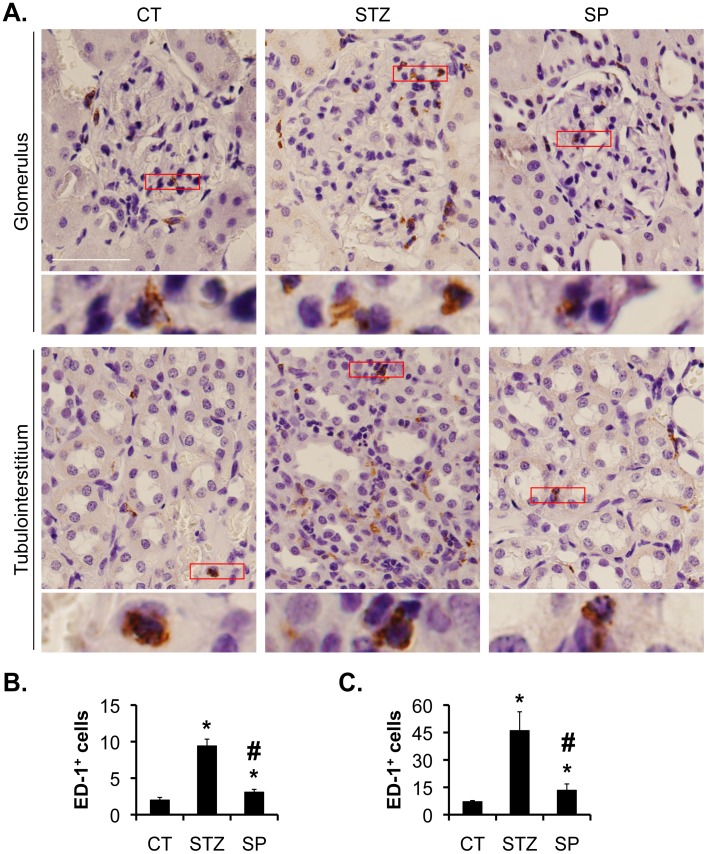
Spironolactone reduces the numbers of glomerular and tubulointerstitial macrophages in STZ-induced diabetic rats.(A) Representative IHC images showing the staining of CD-1, a marker of macrophage, in the kidneys as indicated (A). Boxed areas are amplified and shown at the bottom of each panel. Scale bar: 100 µm and 25 µm for the amplified boxed areas. (B–C) Graphs showing significantly more glomerular (B) and intersterial (C) ED-1-positive cells in STZ vs. CT rats. SP significantly reduced the number of glomerular and tubulointerstitial macrophages in STZ rats.